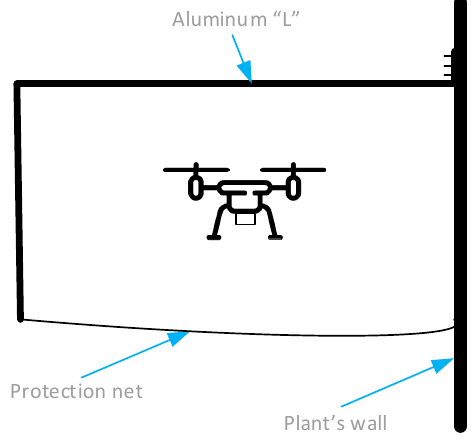
Figure 2. Confined flying corridor, at the perimeter of the plant.